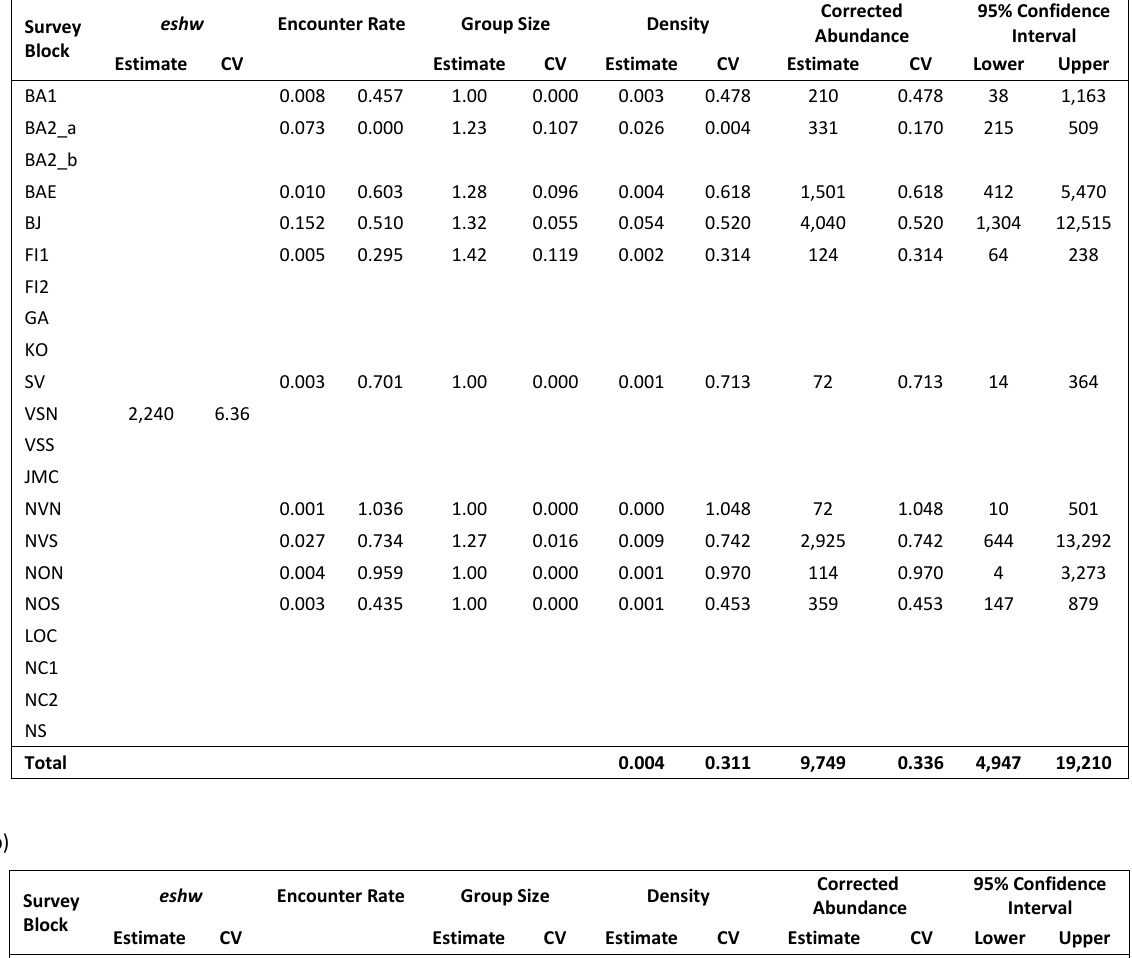
Table 7. Estimated density and abundance of humpback whales from the 2002 – 2007 survey (a) and the 2008 – 2013 survey (b). The eshw (effective search half width (m)) was estimated for the entire study region. Encounter rate, group size, density, abundance, and upper and lower confidence limits were estimated by block and corrected for perception bias, with the estimated p